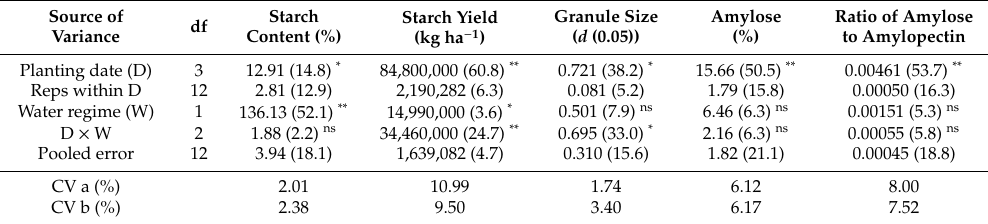
Table 5. Mean squares from combined analysis of variance for starch content, starch yield, granule size ( d (0.05)), amylose content and ratio of amylose to amylopectin of cassava cv. Rayong 9 at harvest stage using four planting